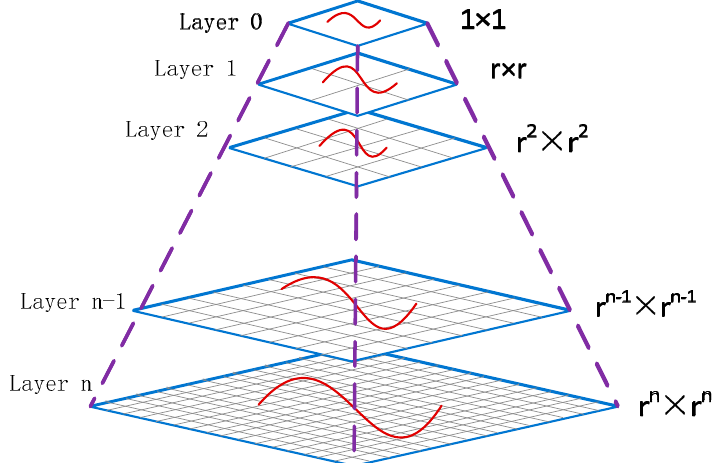
Figure 1. Vector Tiled Pyramid Model.